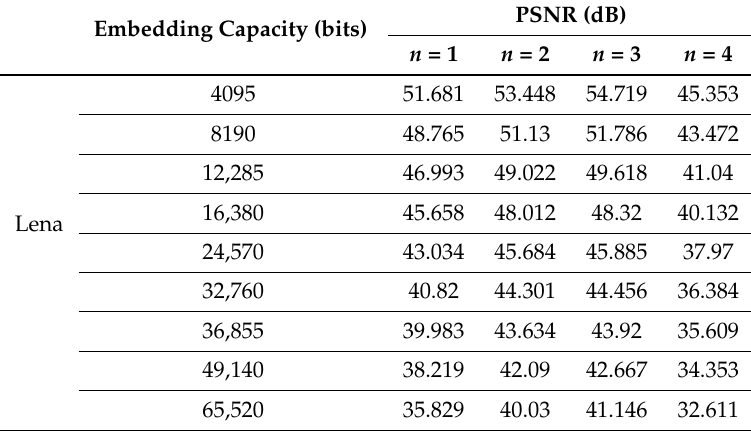
Table 1. Embedding capacity and PSNR values under different n .